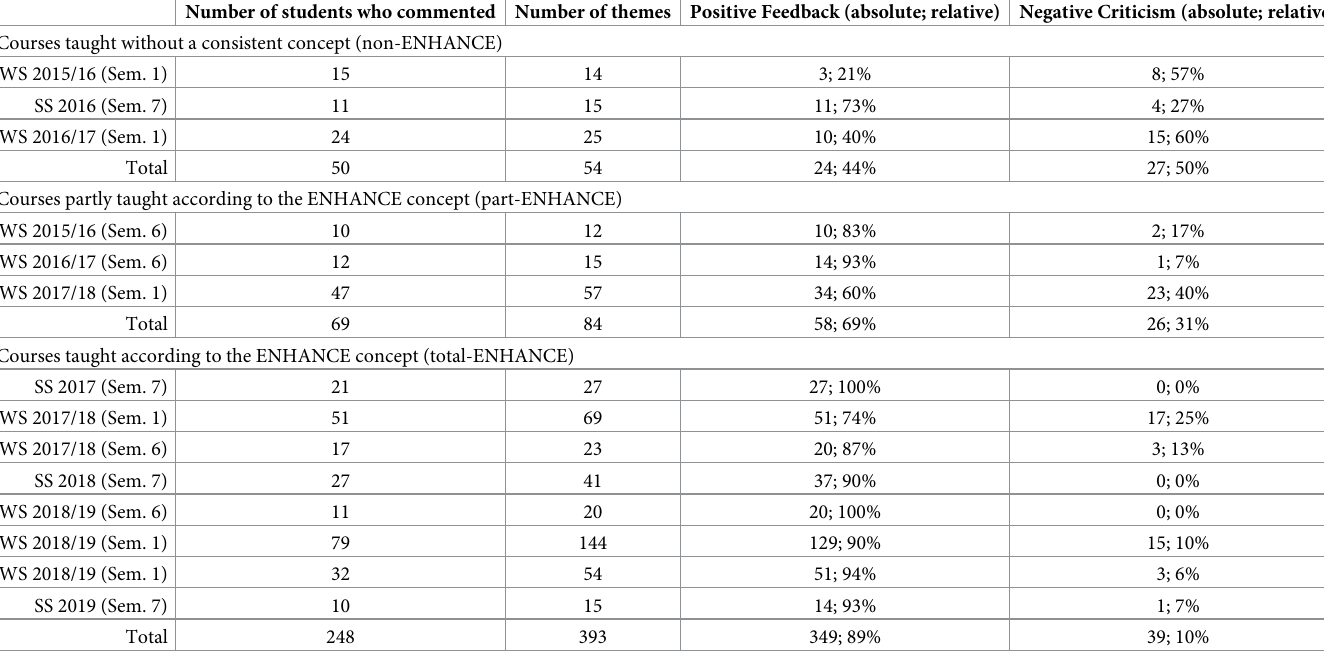
Table 1. Number of comments, themes, positive feedback, and negative criticism for all physics integrated supportive science courses. Number of students who commented Number of themes Positive Feedback (absolute; relative) Negative Criticism (absolute; relative)